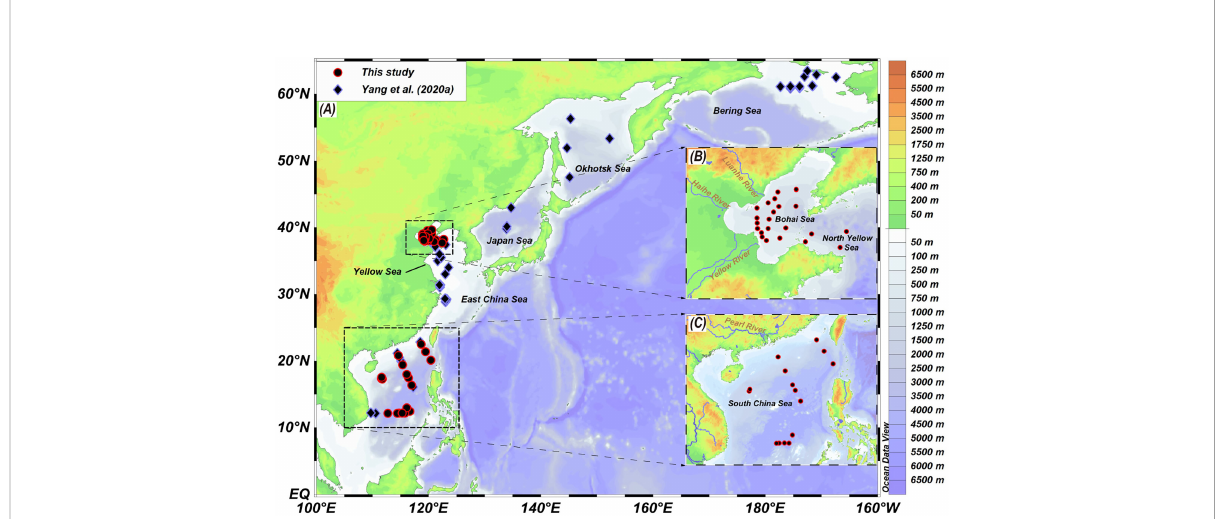
FIGURE 1 Maps showing the location in marine surface sediment samples. (A) Overview map in the North Paci fi c Sea showing all sampling sites (Yang et al., 2020a and this study). (B, C) Local maps showing the locations of surface sediment samples collected from the Bohai Sea and North Yellow Sea, and the South China Sea